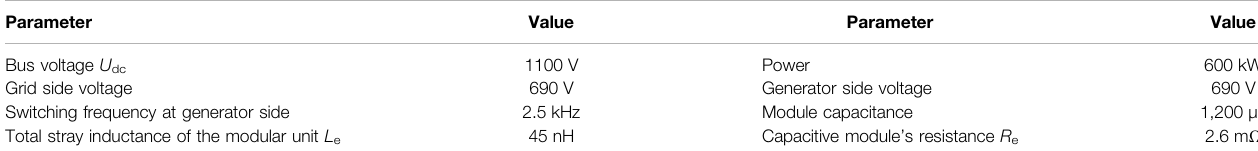
TABLE 2 | Simulation circuit parameters.